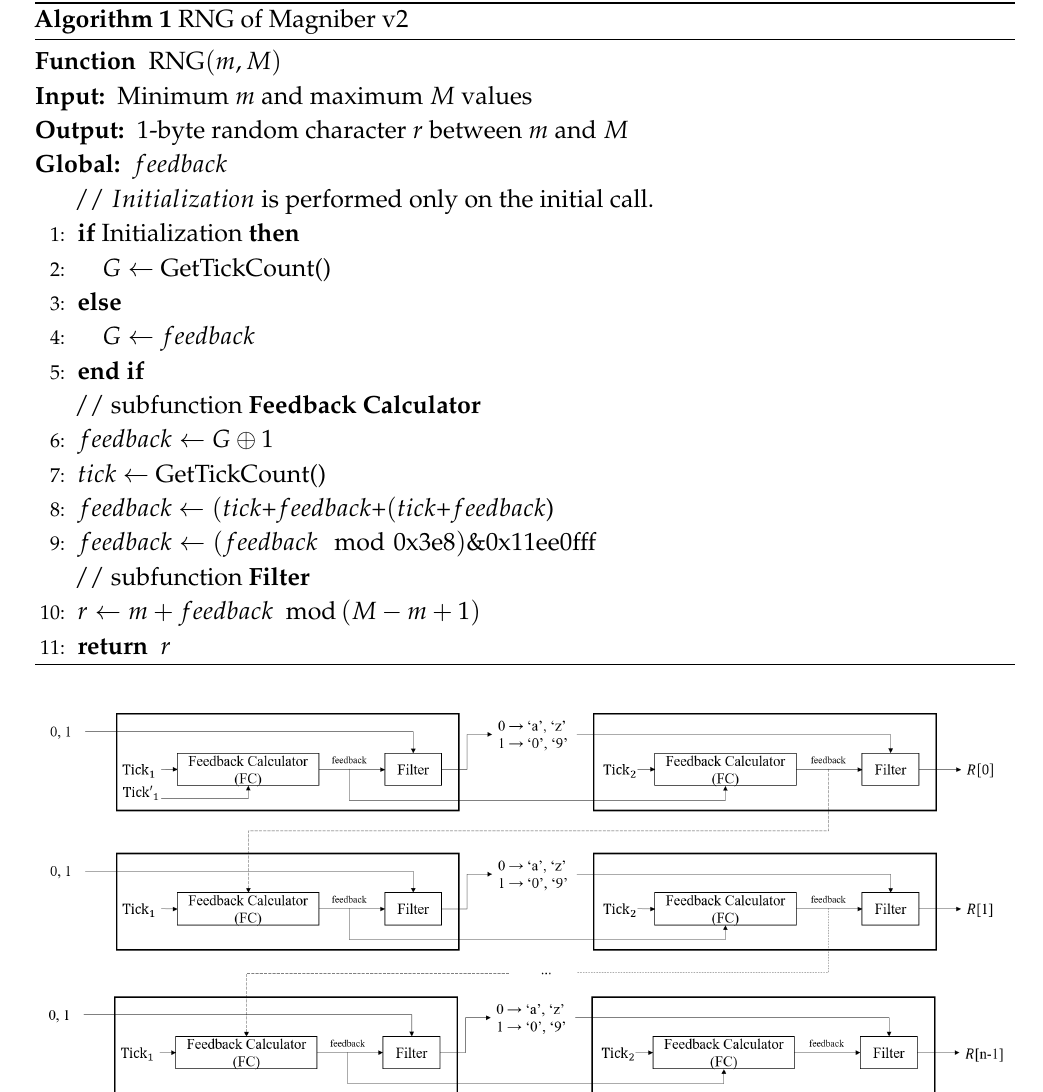
Figure 3. Structure of Magniber’s Pseudo Random Number Generator (PRNG), Magniber PRNG (MPRNG). Algorithm 2 PRNG of Magniber v2 Function MPRNG ( n